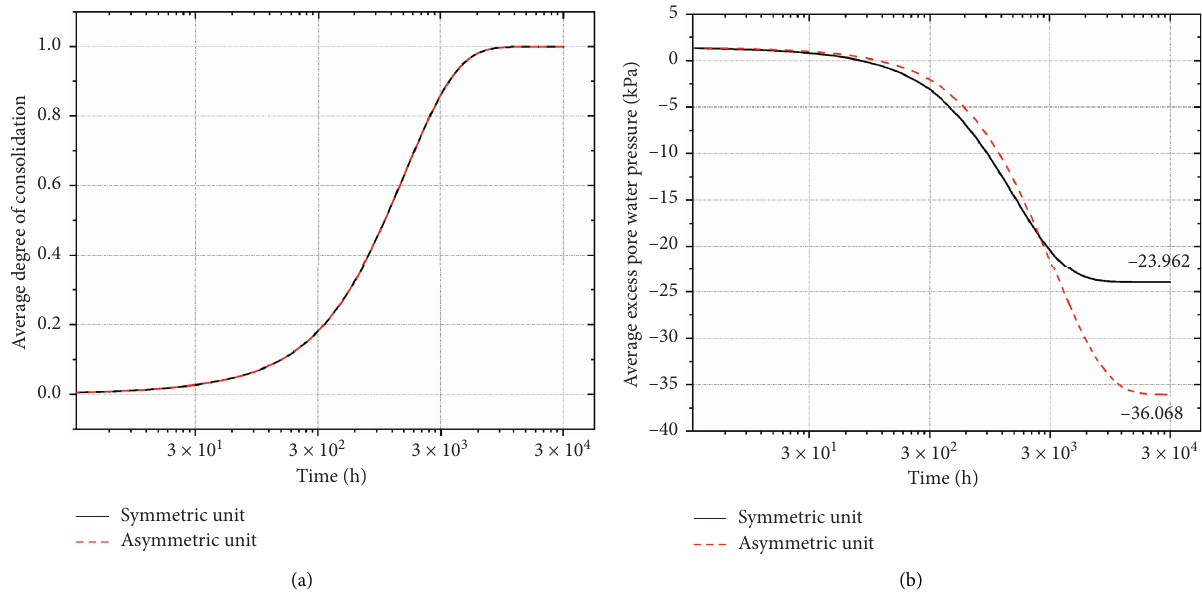
Figure 13: The average degree of consolidation curve and the average excess pore water pressure curve of the unit. (a) The unit average consolidation curve. (b) The curve of excess pore water pressure of